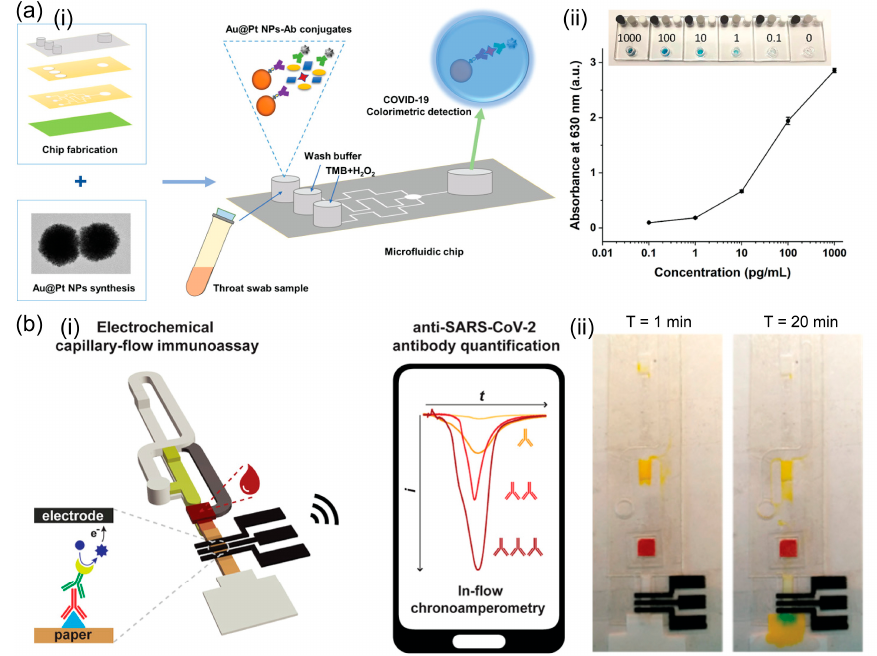
Figure 3. ( a ) Schematic representation of the platinum-decorated gold nanoparticle (Au@Pt NP)-based microfluidic chip immunoassay for COVID-19 detection. (i) Schematic diagram of COVID-19 immunoassay microdevice operation procedure. (ii) Analytical performance: Images of the microfluidic chip immunoassay and absorbance intensity obtained at different concentrations of N protein ranging from 0.1 to 1000 pg/mL. Reprinted with permission from [51]. Copyright (2022) ACS publications. ( b ) Schematic representation of the electrochemical capillary-flow immunoassay for SARS-CoV-2 detection. (i) Schematic overview of the entire smartphone-based detection system using electrochemical capillary-flow immunoassay. (ii) Sequential delivery of blood sample inside a microdevice within 20 min. Reprinted with permission from [57]. Copyright (2021) ACS publications.